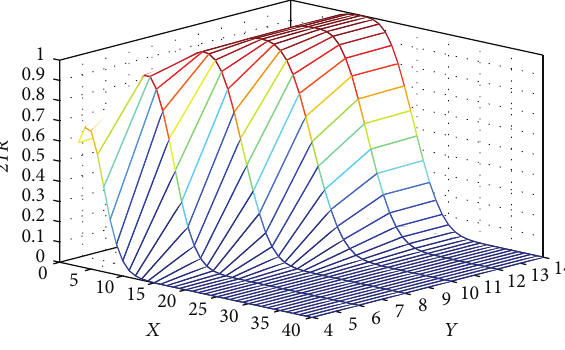
Figure 5: Sensibility of probability of link existence.